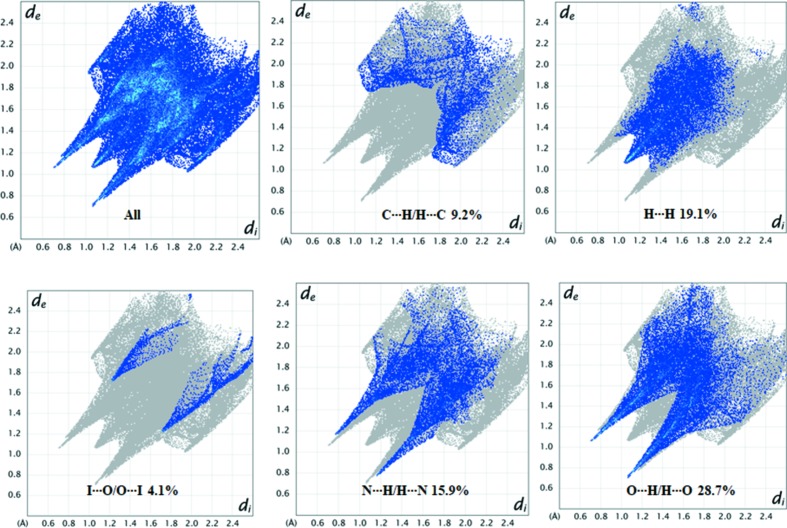
2D fingerprint plots showing the percentages of the contribution of various interactions to the total Hirshfeld surface area of com­pound 1. Full inter­actions (upper row, left) and resolved contacts (upper row: middle, C⋯H/H⋯C; right, H⋯H; lower row: left, I⋯O/O⋯I; middle, N⋯H/H⋯N; right, O⋯H/H⋯O).